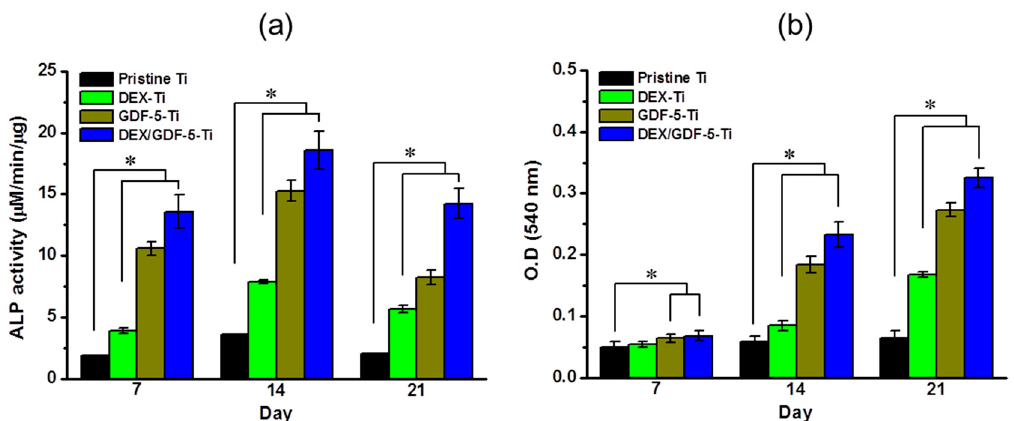
Figure 6. ( a ) Level of (CCK-8) (ALP) activity and ( b ) amount of calcium deposition on pristine Ti, DEX–Ti, GDF-5–Ti and DEX/GDF-5–Ti disc samples cultured with MC3T3-E1 cells for 7, 14 and 21 days. The error bars represent mean ± SD ( n = 3). These experiments were repeated three times (* p < 0.05).